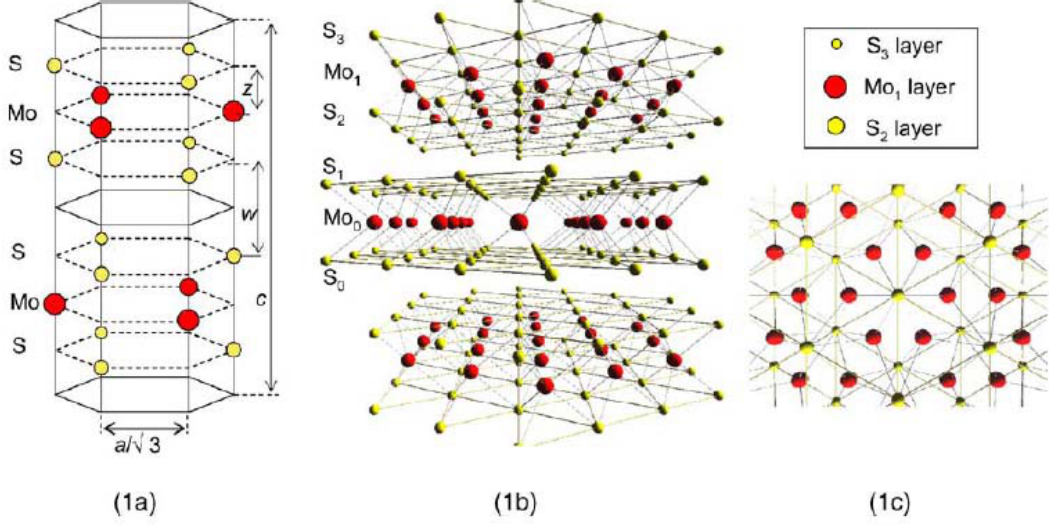
Figure 1. Crystal structure of MoS (1a), side view (1b) and simple projection of one 2 –Mo –S layer seen from Mo atoms lying in Mo sandwich S 2 1 3 surface (1c). Reproduced from reference [39] with permission from